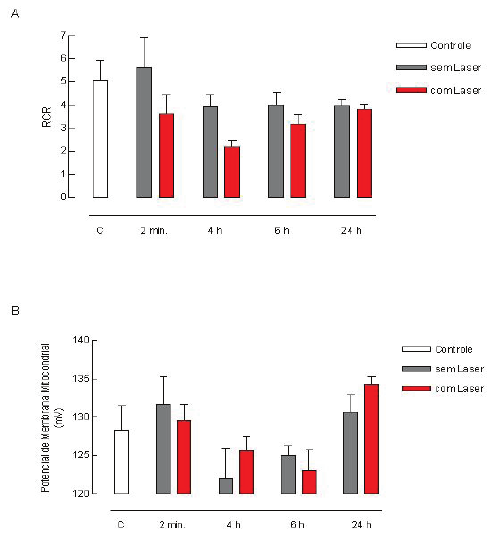
FIGURE 2 – Analysis of mitochondrial bioenergetic before PH (C: control) and after PH (2 min, 4h, 6h, 24 h), in the presence and absence of laser biostimulation. Panel A : values of respiratory control ratio (RCR); Panel B : values of mitochondrial membrance